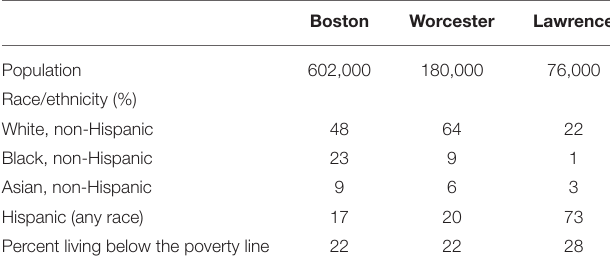
TABLE 1 | Sociodemographic characteristics of partner